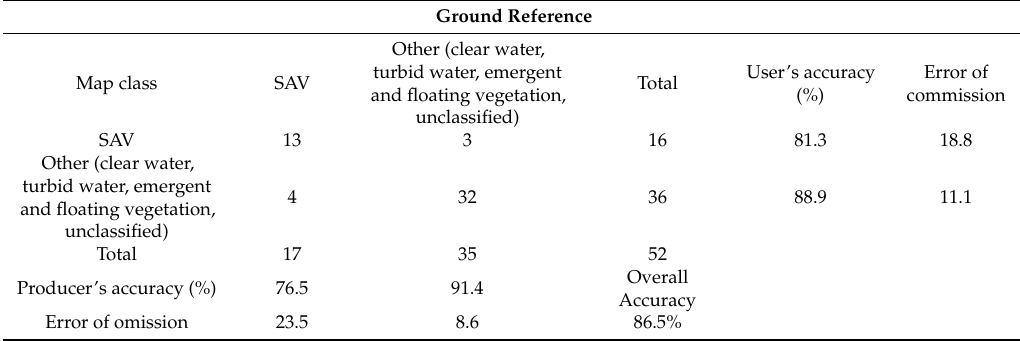
Table 5. Error matrix produced from the field verification data of September 2014. Of 52 points, 45 were verified as correct